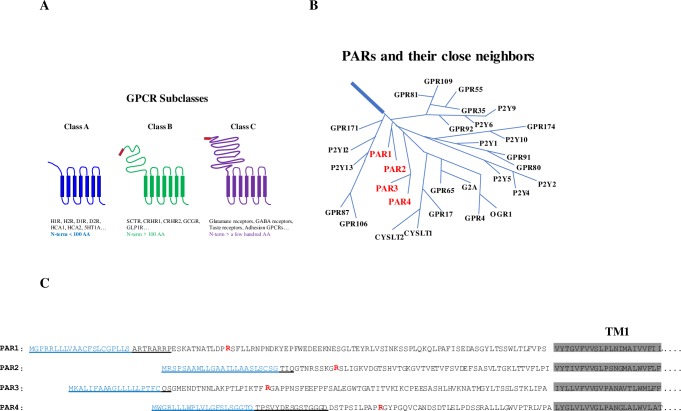
PAR receptors are unique group of receptors in the Class A subfamily.A. Examples of GPCR subfamily members and signal peptide possession. The signal peptide regions in Class B and C are shown in red. B. PAR receptors and their closest neighbors, grouped by sequence similarity. C. The N-terminal amino acid sequence of PAR1-4. The signal peptides are shown in blue. Each PAR receptor is encoded by 2 exons. The protein regions coded by the first exons are underlined. The Arg residues involved in receptor cleavage and activation are shown in red.